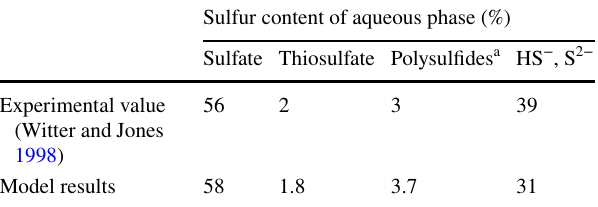
Table 5 Sulfur speciation at 25 °C and 101 kPa, pH =